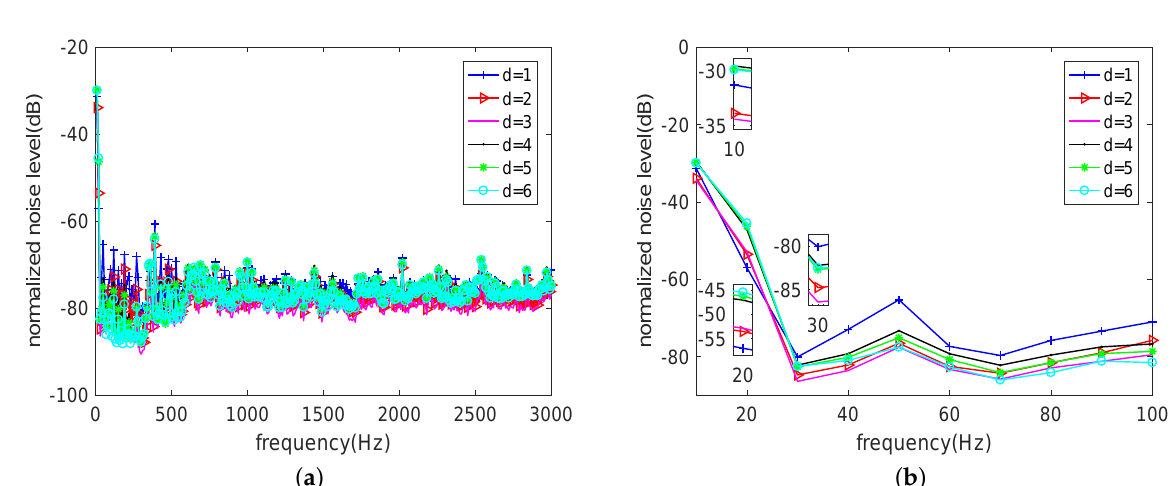
Figure 7. ( a ) Comparison of normalized noise level under different numbers of (unilateral) peaks/valleys included for processing; ( b ) a magnified version of ( a ) at 10 ∼ 100 Hz.